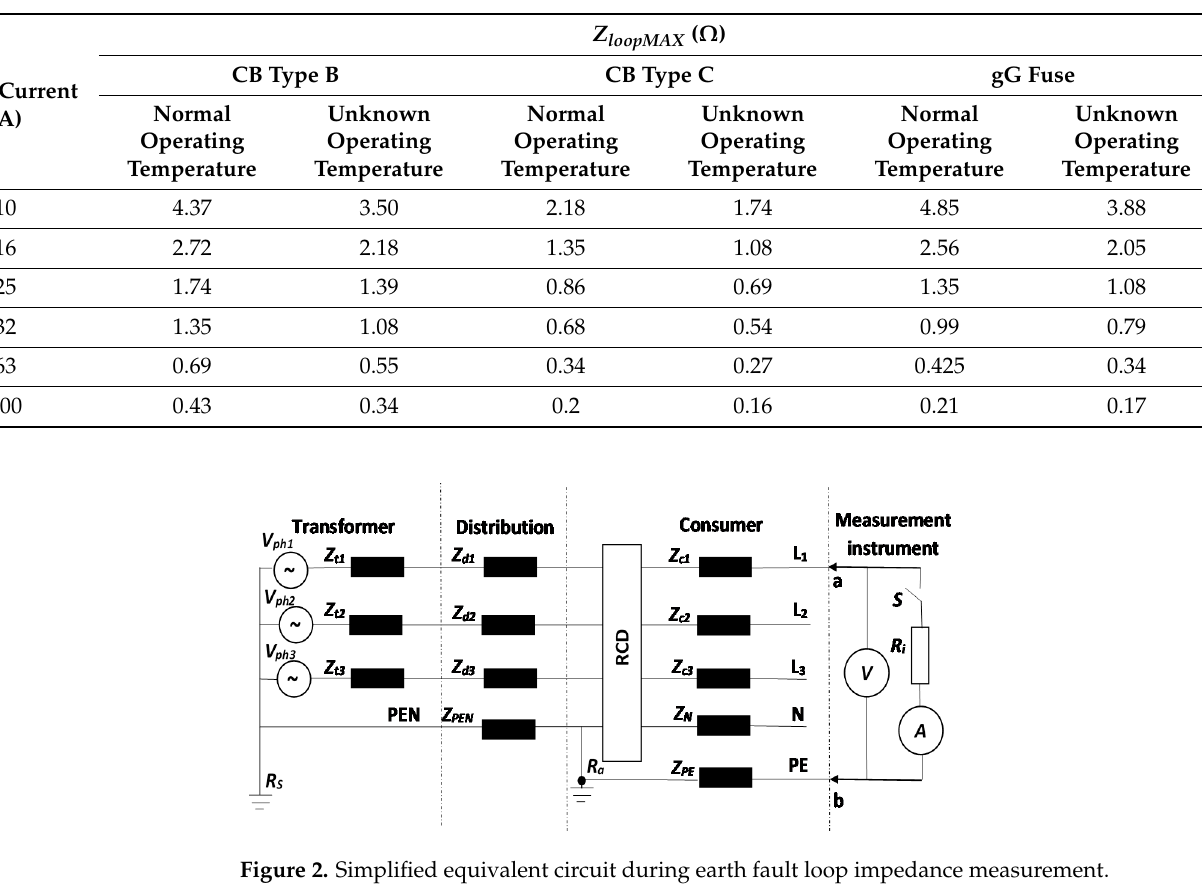
Table 2. Maximum measured values of the earth fault loop impedance at normal and at the unknown operating temperature.